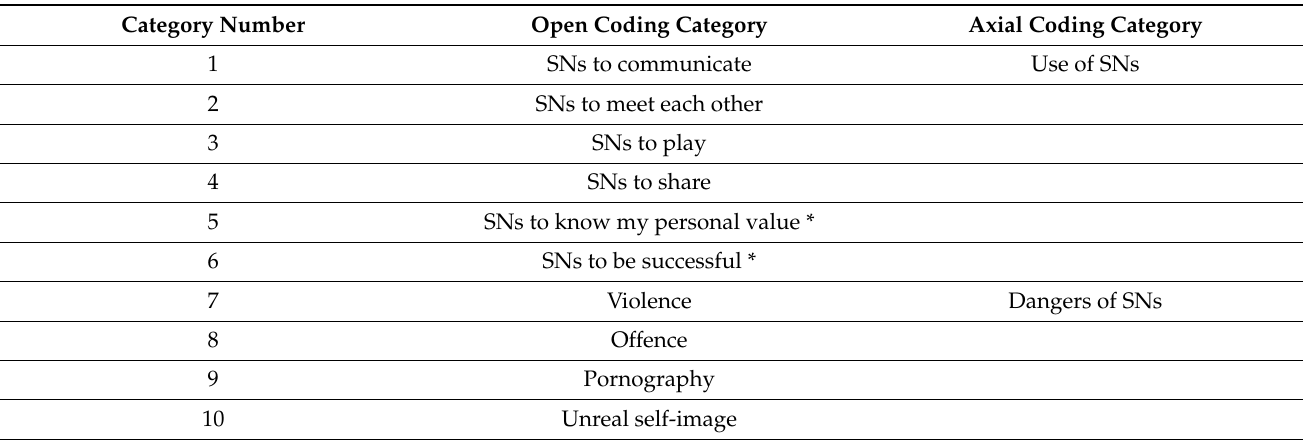
Table 2. Content of axial coding categories.